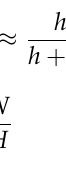
Figure 3. LC morphology of single channel and geometric feature.